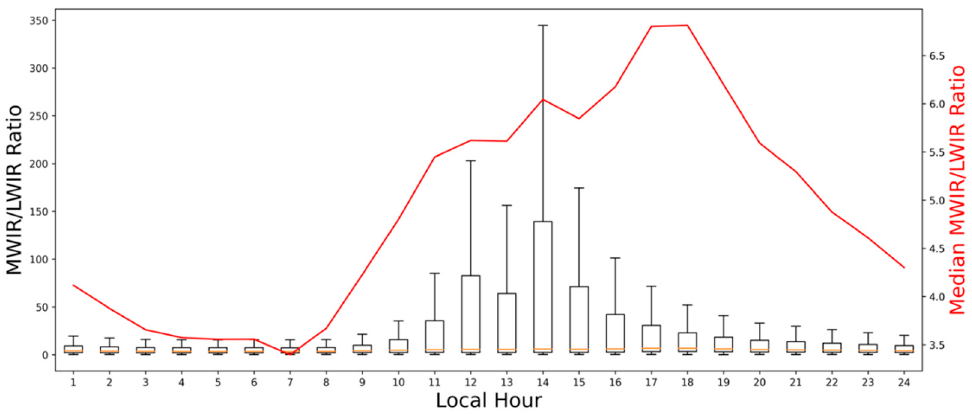
Figure A4. Map of the study region showing gridded (1-arcminute; ~2 km) AHI active fire detection locations for September and October 2015, coloured by the median spectral ratio for each grid cell (defined in Section 4.2).